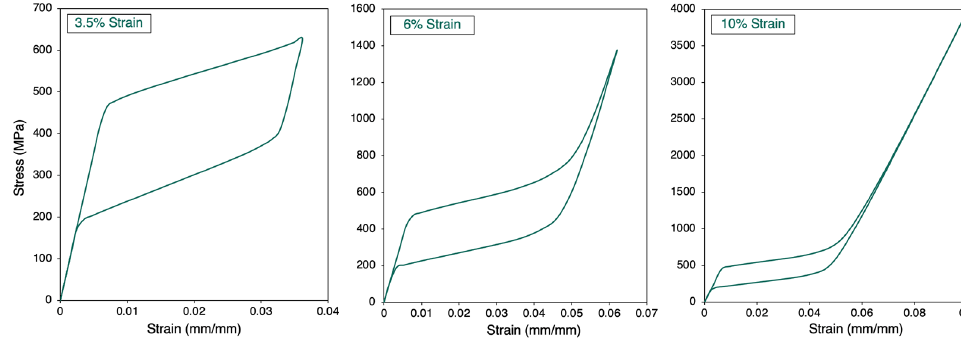
Figure 13. Comparison of experimental data and combined plastic model.